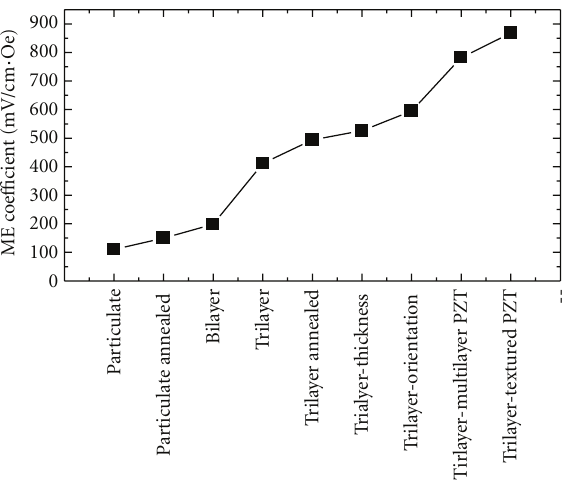
Figure 29: Progress in magnetoelectric sintered